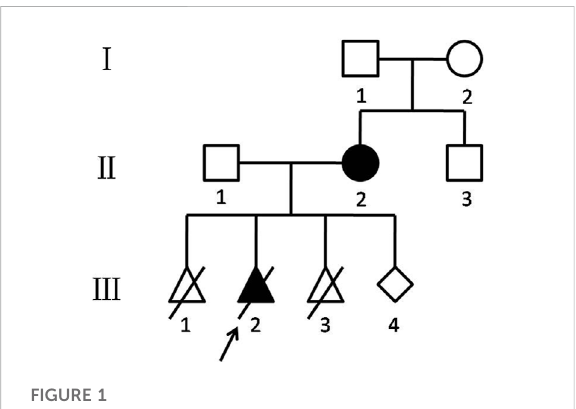
FIGURE 1 Chinese KOS/TS pedigree. Black- fi lled symbols indicate patients who suffered from TS ( Ⅱ 2) and KOS ( Ⅲ 2). The proband ( Ⅲ 2)isindicatedby an arrow. Ⅲ 1 was ended byarti fi cial abortion at 7 weeks. Ⅲ 2 was inducedlabor at 32 weeks. Ⅲ 3 was revealed as a biochemical